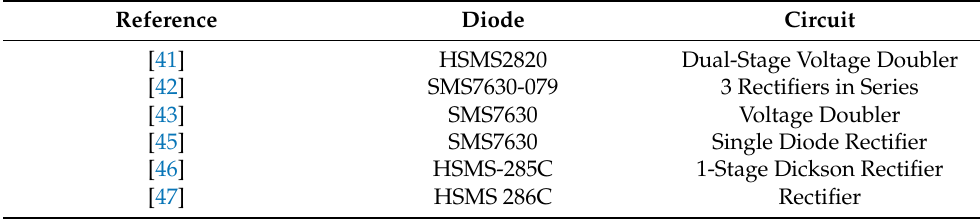
Table 4. Types of diodes that are utilized in various rectifiers’